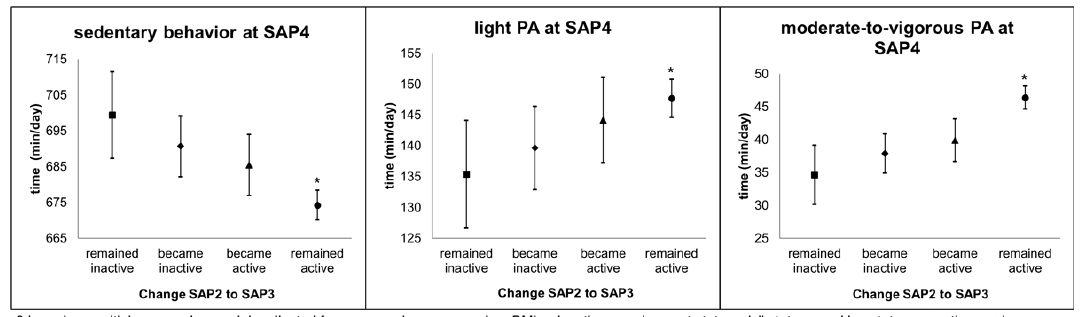
Figure 4: Adjusted mean minutes per day in specific levels of physical activity intensity objectively measured at SAPALDIA4 (2017/18), ac- cording to self-reported moderate-to-vigorous physical activity change patterns from SAPALDIA2 (2001/02) to SAPALDIA3 (2010/11) (re- mained inactive n = 87; became inactive n = 162; became active n = 175; remained active = 729 according to Swiss recommendation for Physical Activity cut-offs). All analyses were adjusted for sex, age, body mass index, language region, education, employment status, civil sta- tus, smoking status, wear time and season An asterisk * indicates a p-value of